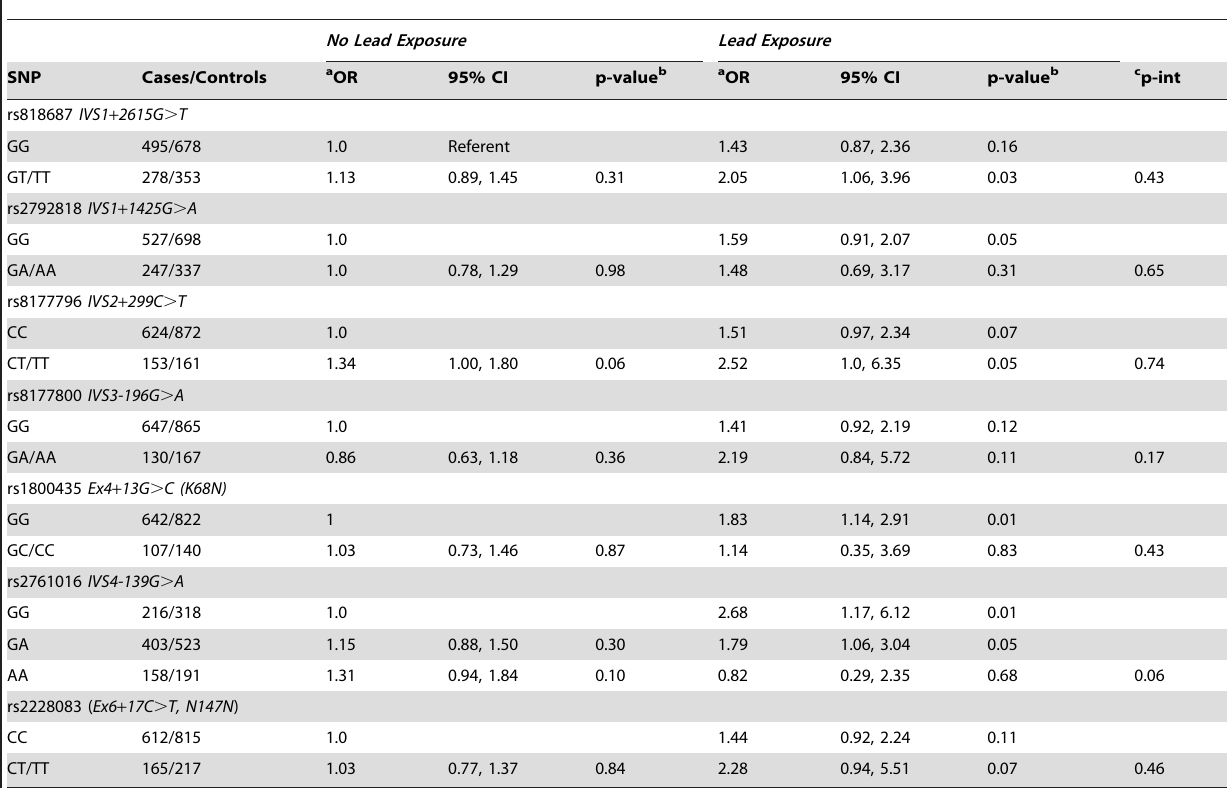
Table 3. Odds ratio (OR) and 95% confidence intervals (CI) for joint ALAD tagging SNP genotypes, occupational lead exposure and renal cancer risk.